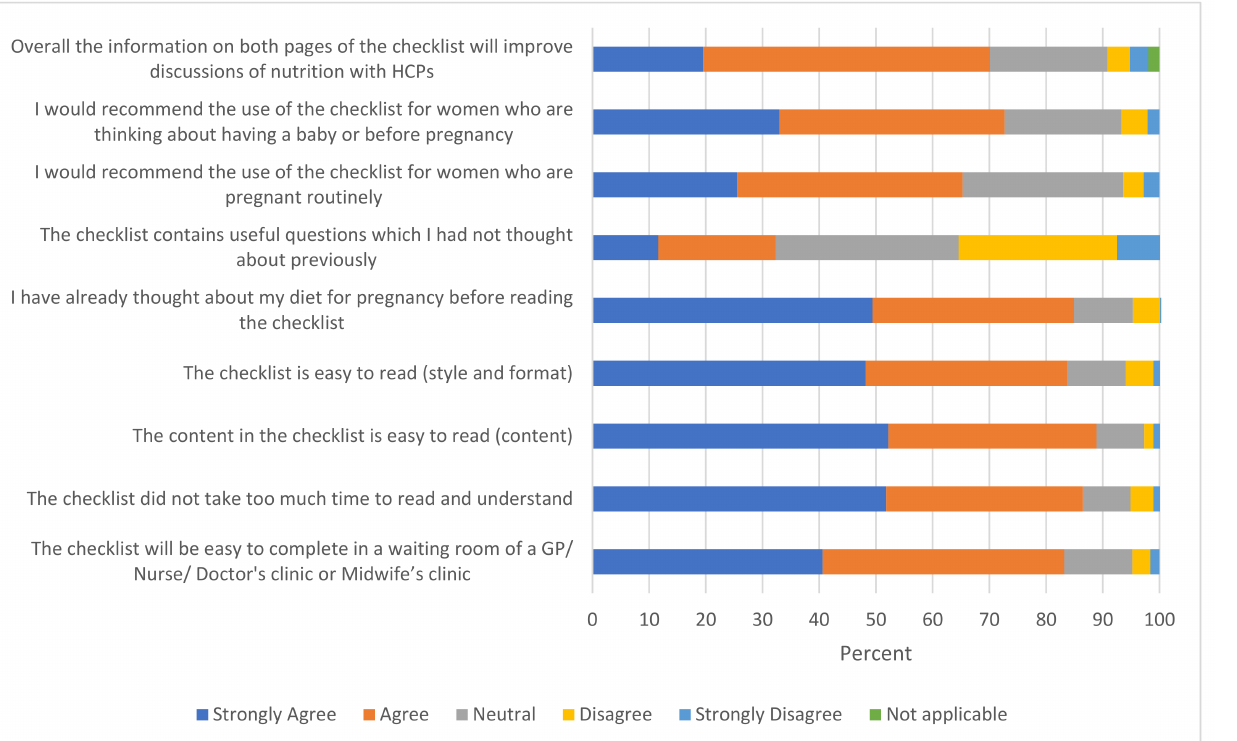
Figure 2. Findings for the questions on acceptability of the checklist from a survey of women in the reproductive age group (total sample N = 251; for the question on “recommends the checklist before pregnancy” N = 194; “thought about diet before pregnancy” N = 231). GP, general